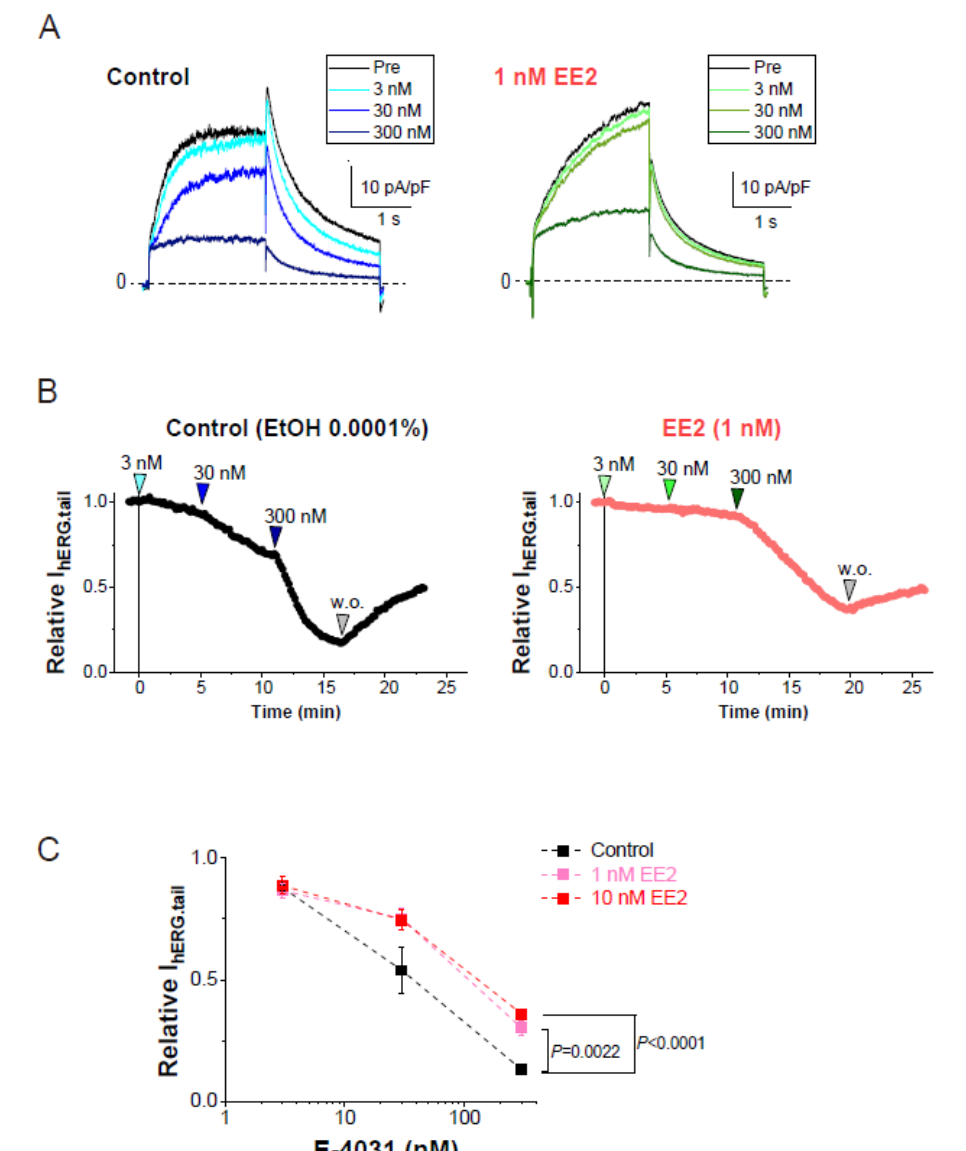
Figure 2. Blockade of hERG currents by E-4031 with or without EE2. hERG currents were recorded from HEK293 cells using the scheme as that described in Figure 1D. The hERG channels were sequentially activated at 0.1 Hz by 20-mV test pulses for 2 s from a holding potential (V h ) at − 80 mV, whereas tail currents were recorded with a repolarizing step to − 40 mV. EE2 at 1 nM was administered 5 min prior to the cumulative application of E-4031. ( A ). Representative traces in the presence of EtOH (left) and EE2 (right) are shown by superimposing the traces before (control) and after the addition of E-4031 (3, 30 and 300 nM). Scale, 10 pA/pF, 1 s. ( B ). Time course of hERG inhibition by cumulative application of E-4031 in the presence of 0.0001% EtOH (left) and 1 nM EE2 (right). After the current amplitudes were stabilized for 1 min, E-4031 was added in the presence of EtOH or EE2. The timing of E-4031 applications (3, 30, and 300 nM) indicated by the arrowheads above the plot. ( C ). Concentration-dependent inhibition of E-4031 was plotted as relative values of the tail amplitudes compared to the right before the application of E-4031. Colored lines indicate the presence of EE2. Control (no EE2); n = 8, EE2 at 1 nM; n = 8, EE2 at 10 nM; n =